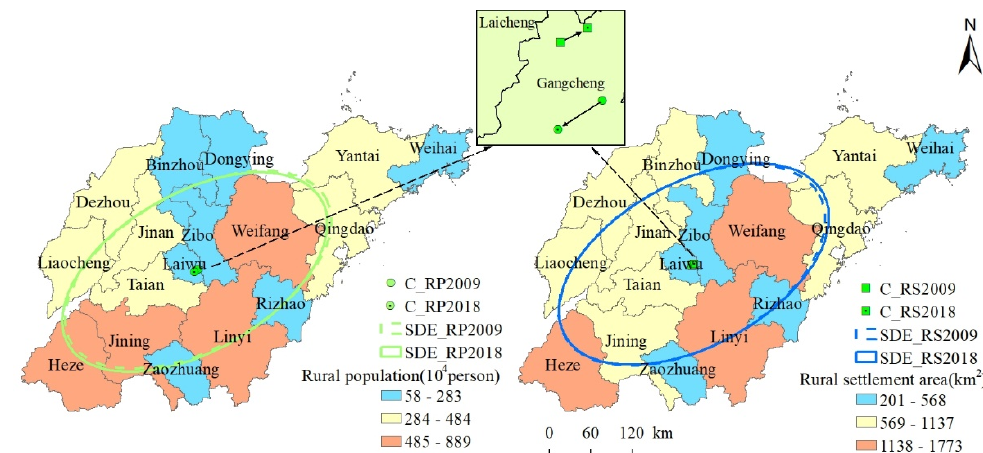
Figure 5. Spatial characteristics of the rural population and rural settlements. Notes : C_RP2009 and C_RP2018 are the center of the rural population in 2009 and 2018, respectively. SDE_RP2009 and SDE_RP2018 are the standard deviation ellipse of the rural population in 2009 and 2018, respectively. C_RS2009 and C_RS2018 are the center of the rural settlement area in 2009 and 2018, respectively. SDE_RS2009 and SDE_RS2018 are the standard deviation ellipse of the rural settlement area in 2009 and 2018, respectively.